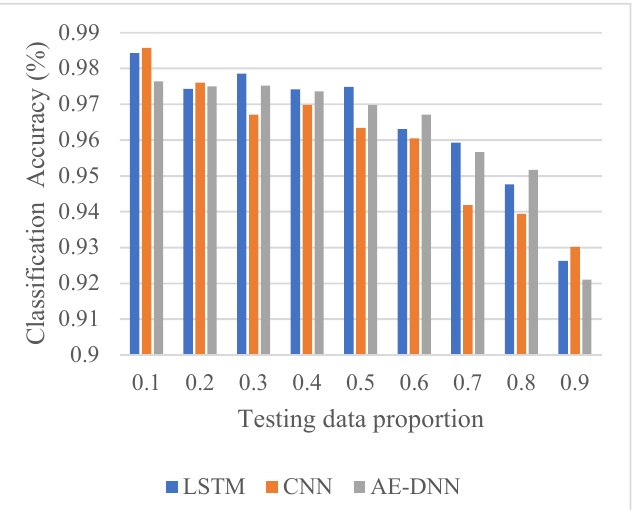
Figure 9. Comparison of detection accuracy.